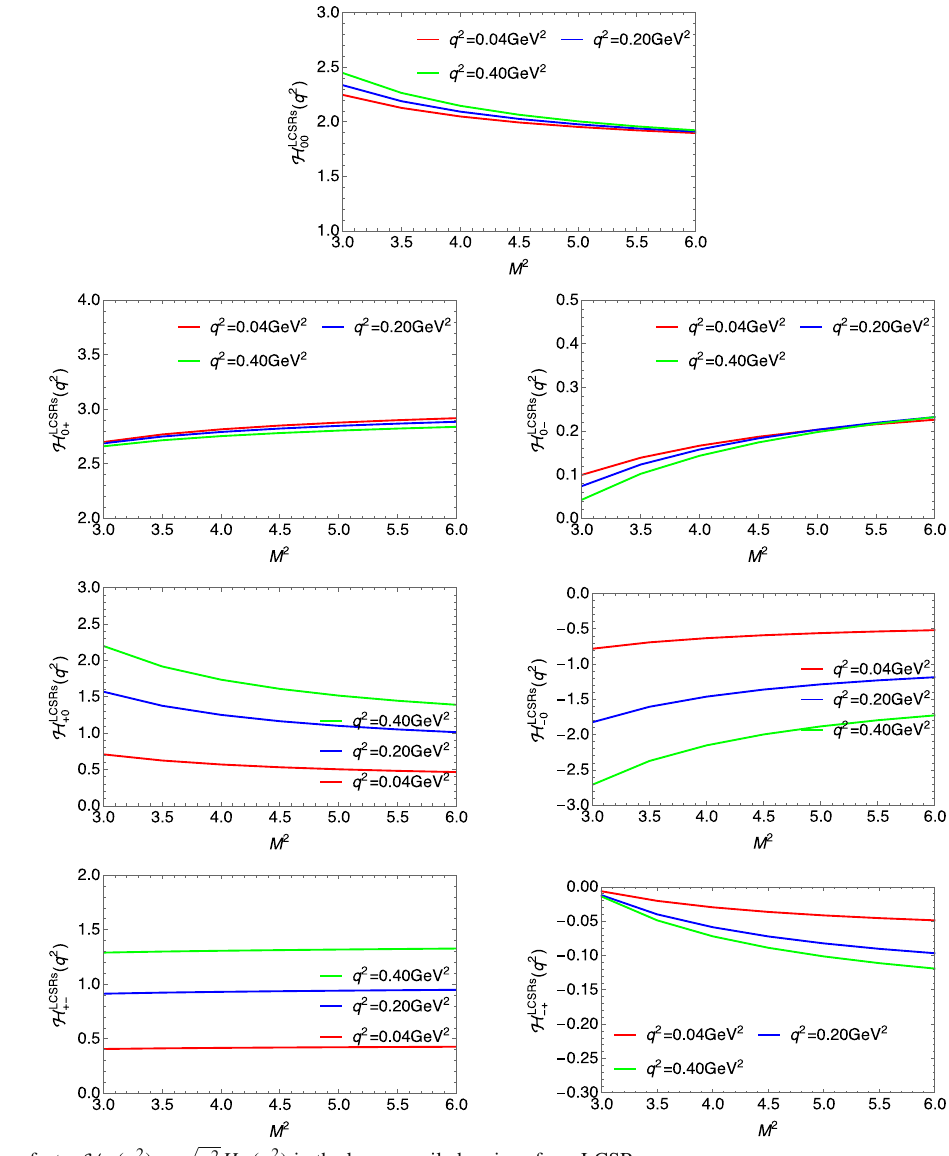
Fig. 2 The Borel mass